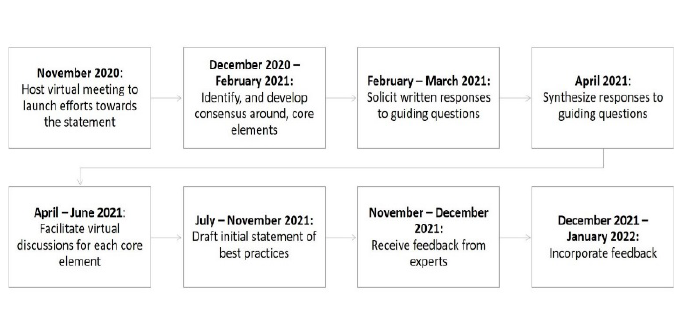
Figure 1 The best practices for searching for evidence during public health emergencies were developed through 8